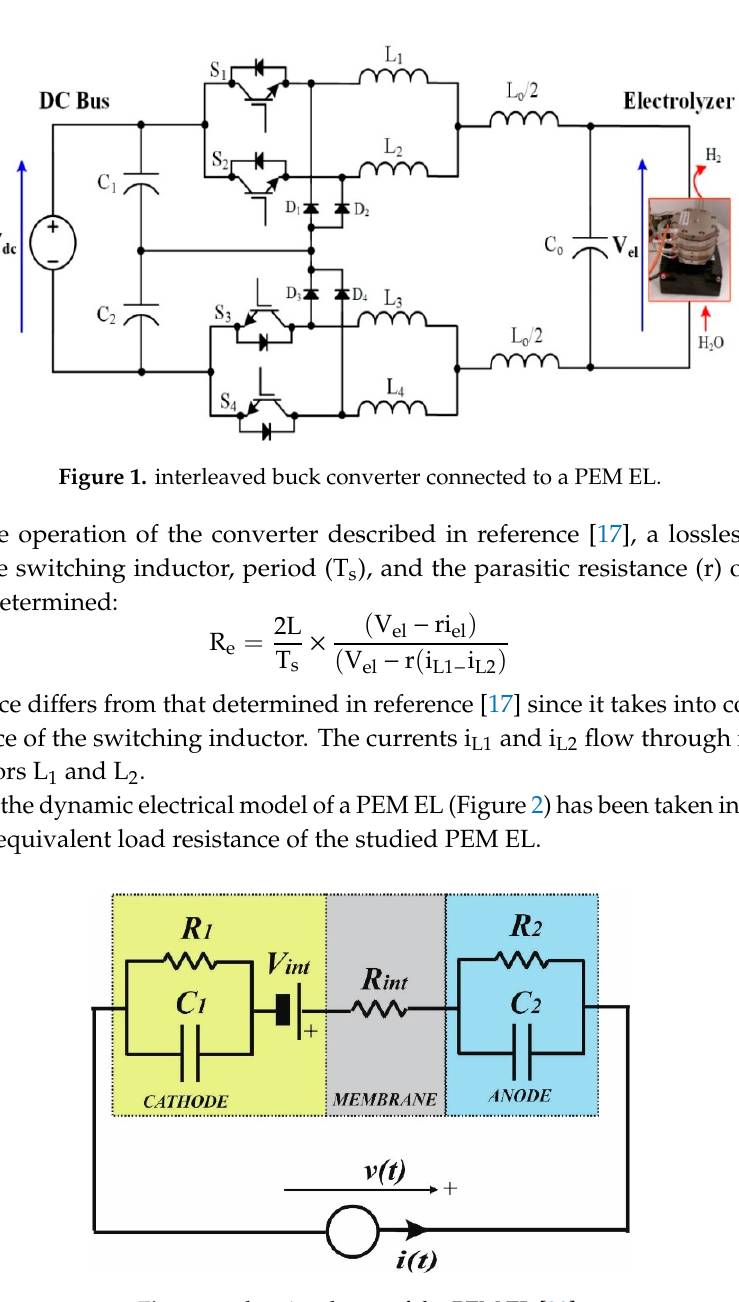
Figure 2. electric scheme of the PEM EL [20].